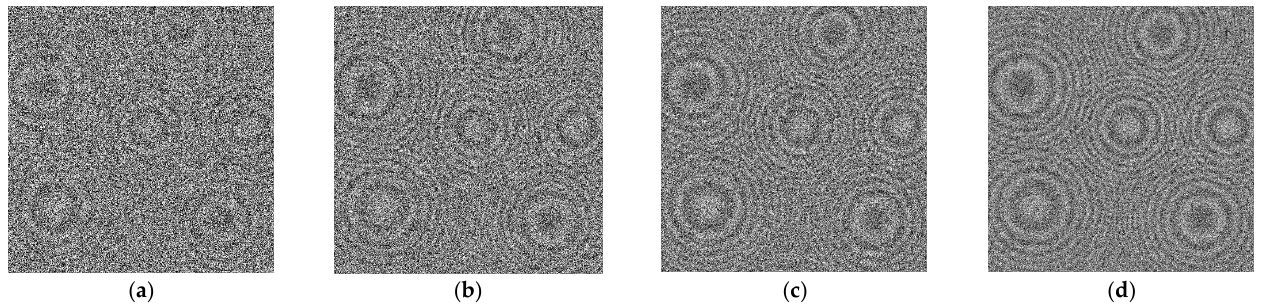
Figure 11. The original fringe patterns in Figure 3a with additive Gaussian noise under different SNR values: ( a ) 1 dB; ( b ) 3 dB; ( c ) 5 dB; and ( d ) 7